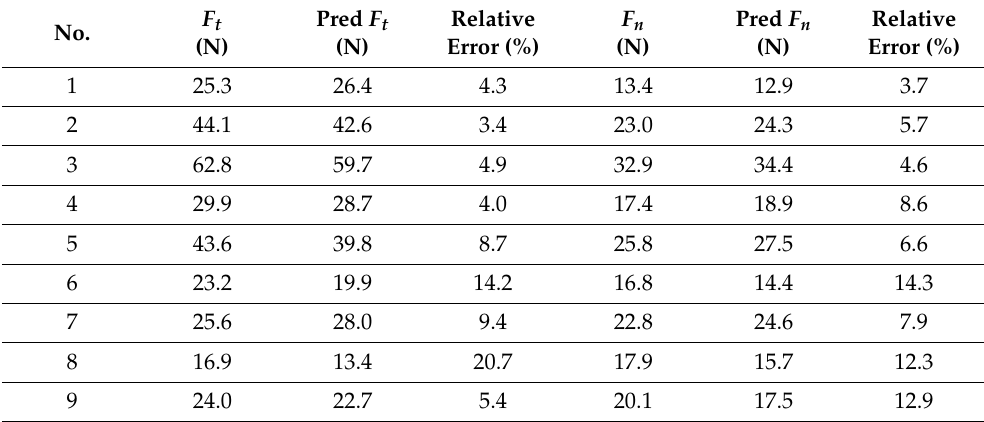
Table 12. The relative errors of the milling forces and predictions for each